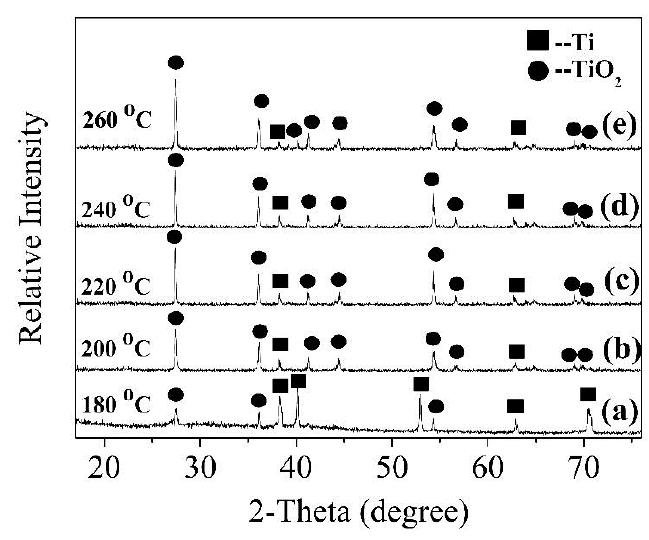
Figure 4. XRD patterns of samples prepared at different temperatures. ( a ) 180 °C; ( b ) 200 °C; ( c ) 220 °C; ( d ) 240 °C; ( e ) 260 °C.